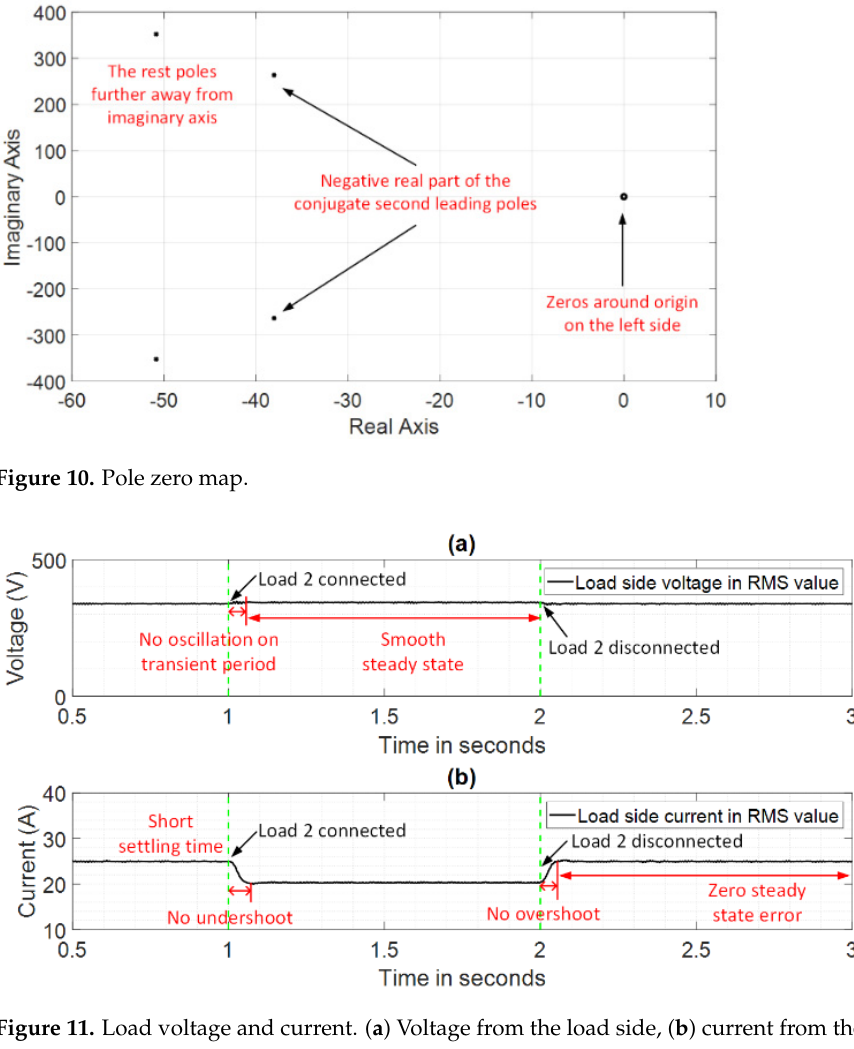
Figure 11. Load voltage and current. ( a ) Voltage from the load side, ( b ) current from the load